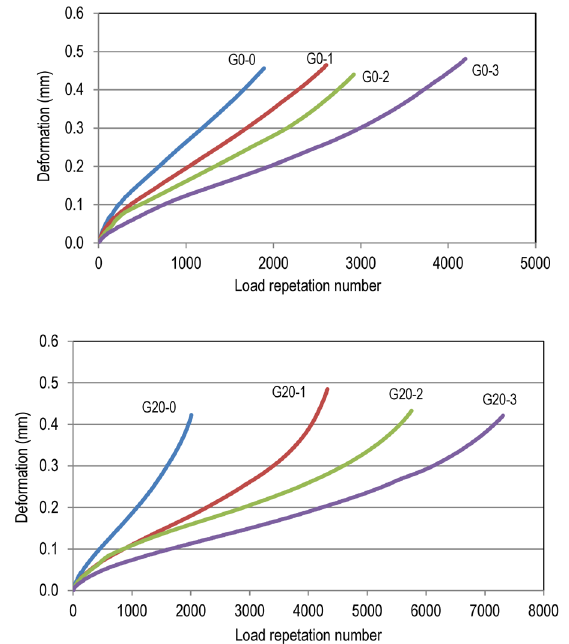
Fig. 7. The stress-deformation relation of the asphalt mixtures with aging